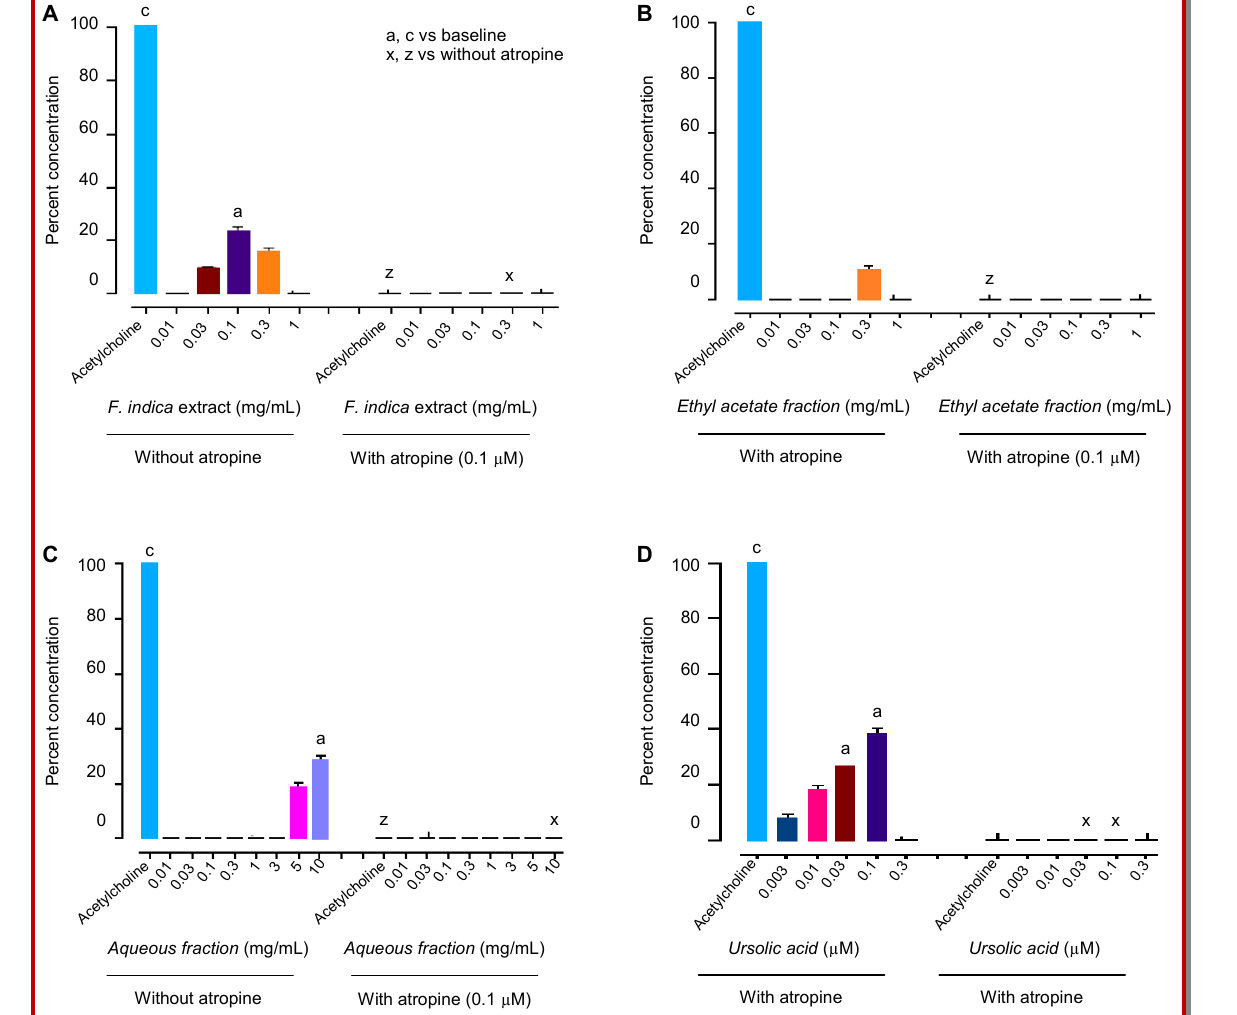
Figure 2: The concentration-dependent stimulatory effect of the crude extract of Fagonia indica (A) its ethyl acetate; (B) aqueous fractions; (C) and ursolic acid; (D) without and with atropine (0.1 μ M) in isolated mice ileum. Values are expressed as mean ± SEM, n= 4-6. a / x p<0.05 and c / z p<0.01. “ a, c ” shows comparison with baseline (One - way ANOVA tailed with Dunnett's test). “ x, z” show comparison of atropine pretreated vs. without atropine pretreated groups (One-way ANOVA tailed with Bonferroni